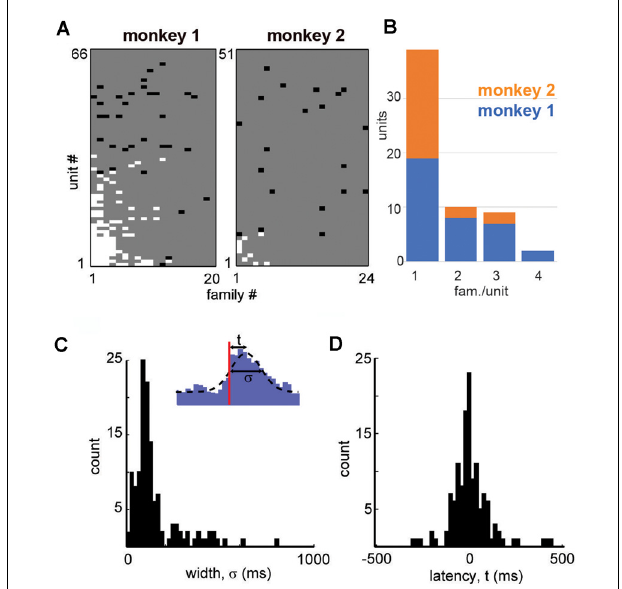
FIGURE 4 | Summary in family selectivity and temporal precision in a unit-family relationship. (A) Summary of all unit-family relationships for both monkeys. White pixels indicate firing increase, black pixels indicate a decrease in the firing. (B) Histogram of units and the number of selective families for both monkeys. (C) We estimated the latency t to peak firing and the width σ of the PETH peak for each strong unit-family pair, by fitting a Gaussian function with an offset ( inset ). The distribution in PETH widths peaked around 100 ms but was also widespread. (D) Peak unit firing centered near t = 0 but could precede or follow the occurrence of a family by up to 100